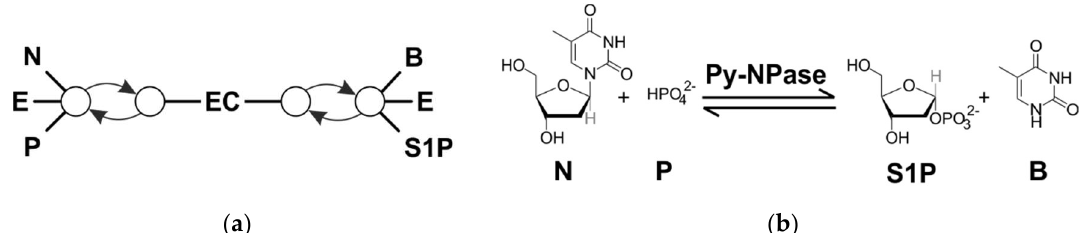
Figure 1. Schematic and chemical illustration of an enzymatic nucleoside phosphorylation. ( a ) Schematic drawing of the proposed mechanics for an enzymatic nucleoside phosphorylation reaction as basis for the generation of the differential–dynamical model. Enzyme (E), nucleoside (N), and phosphate (P) react in a three-particle collision towards the enzyme complex (EC), which decays without other intermediates into enzyme, pentose-1-phosphate (S1P), and free nucleobase (B). Both reactions can occur in the other direction, as well; ( b ) chemical structures of an enzymatic phosphorylation using the example of the enzyme pyrimidine-nucleoside phosphorylase (Py-NPase; E) catalyzed reaction of the nucleoside deoxythymidine (N) and ortho-phosphate (P) to the free nucleobase thymine (B) and deoxyribose-1-phosphate (S1P).